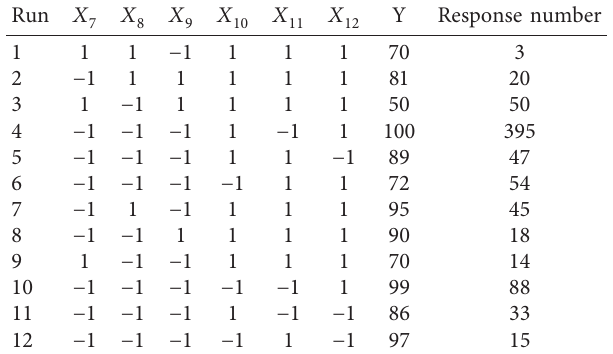
Table 12: One replicate for Example 4.